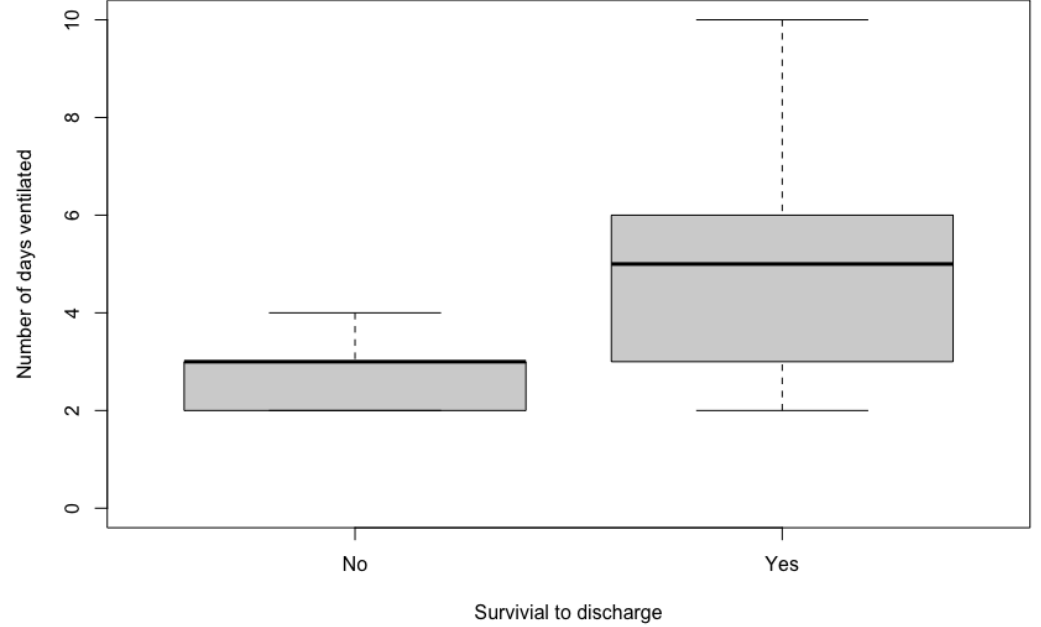
Figure 1. Box and whisker plot comparing the number of days of mechanical ventilation between survivors and non-survivors.